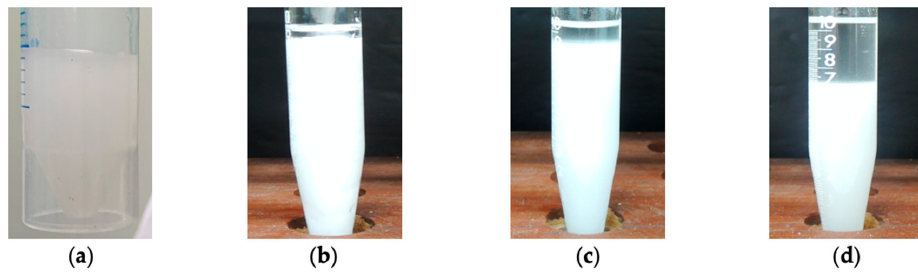
Figure 8. CNC- g -PNIPAM2 dispersed at ( a ) olefin; ( b ) 20/80 water/olefin; ( c ) 20/80 brine/olefin; ( d ) 40/60 brine/olefin. When brine (NaCl at saturation) was added (Figure 8c), a small amount of the olefin phase separated from the emulsion, similar to that observed for the water/olefin suspen- sion. Phase separation increased when the brine/olefin ratio changed from 20/80 to 40/60 (the same applied to the fluids; Figure 8d). As isopropyl groups of PNIPAM contracted in the presence of NaCl, some olefin escaped to the filtrate. However, the amount of oil on the filtrate was low and would not compromise the rock formation stability. Further in- vestigation is needed to improve the understanding of gelled polymer-decorated cellulose nanocrystal systems and the parameters that can control their performance on drilling fluids. 3. Materials and Methods 3.1. Materials Cotton fibers (CFs) were purchased from York company (Brazil) and used as the cel- lulose source without any further purification. Sulfuric acid (hydrolysis agent) was pur- chased from Synth ® (Brazil). N -isopropylacrylamide (NIPAM, monomer) was supplied by Sigma Aldrich (Brazil), and potassium persulphate (K 2 S 2 O 8 , free-radical initiator) was pur- chased from Vetec Química Fina (Brazil). Olefin (8-hexadecene), donated by PETORBRAS (Brazil), was used as the continuous phase of the synthetic-based drilling fluids. The following commercial additives were used to prepare the drilling fluids: BDF − TM 997 (fatty acid polyamide, emulsifier), BDF − TM 998 (fatty acid polyamide, emulsifier), lime (Cao, pH enhancer), ADAPTA ® L (polymer suspension, filtration control agent for organoclay-free oil-based drilling fluids), TAU- MOD ® (elongated inorganic particles, viscosifier for organoclay-free oil-based drilling flu- ids) [37], calcite (CaCO 3 , bridging agent), barite (Ba 2 SO 4 , weighting material), and sodium chloride (NaCl, for brine preparation). The additives were provided by PETROBRAS.